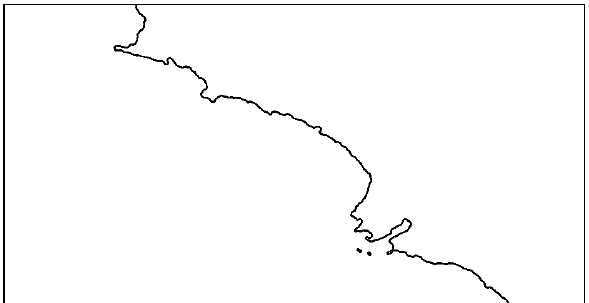
Figure10. Automated extorted coastline converted to vector data.